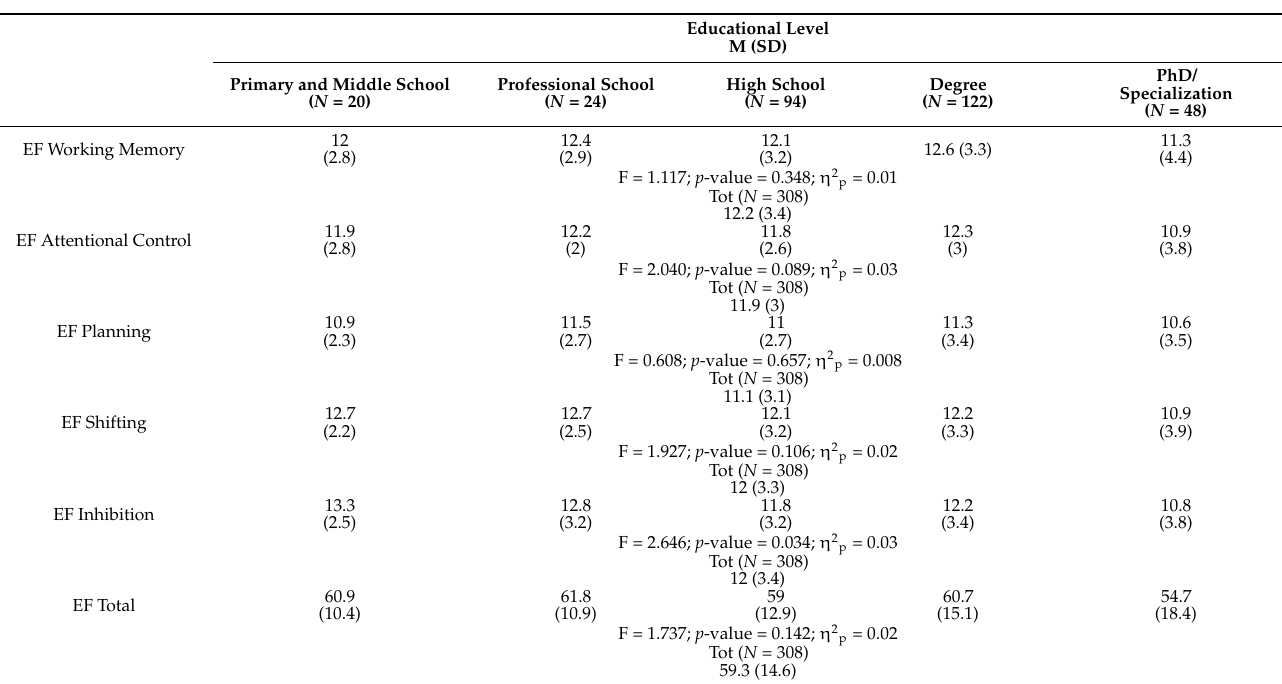
Table 8. EF descriptive data for educational